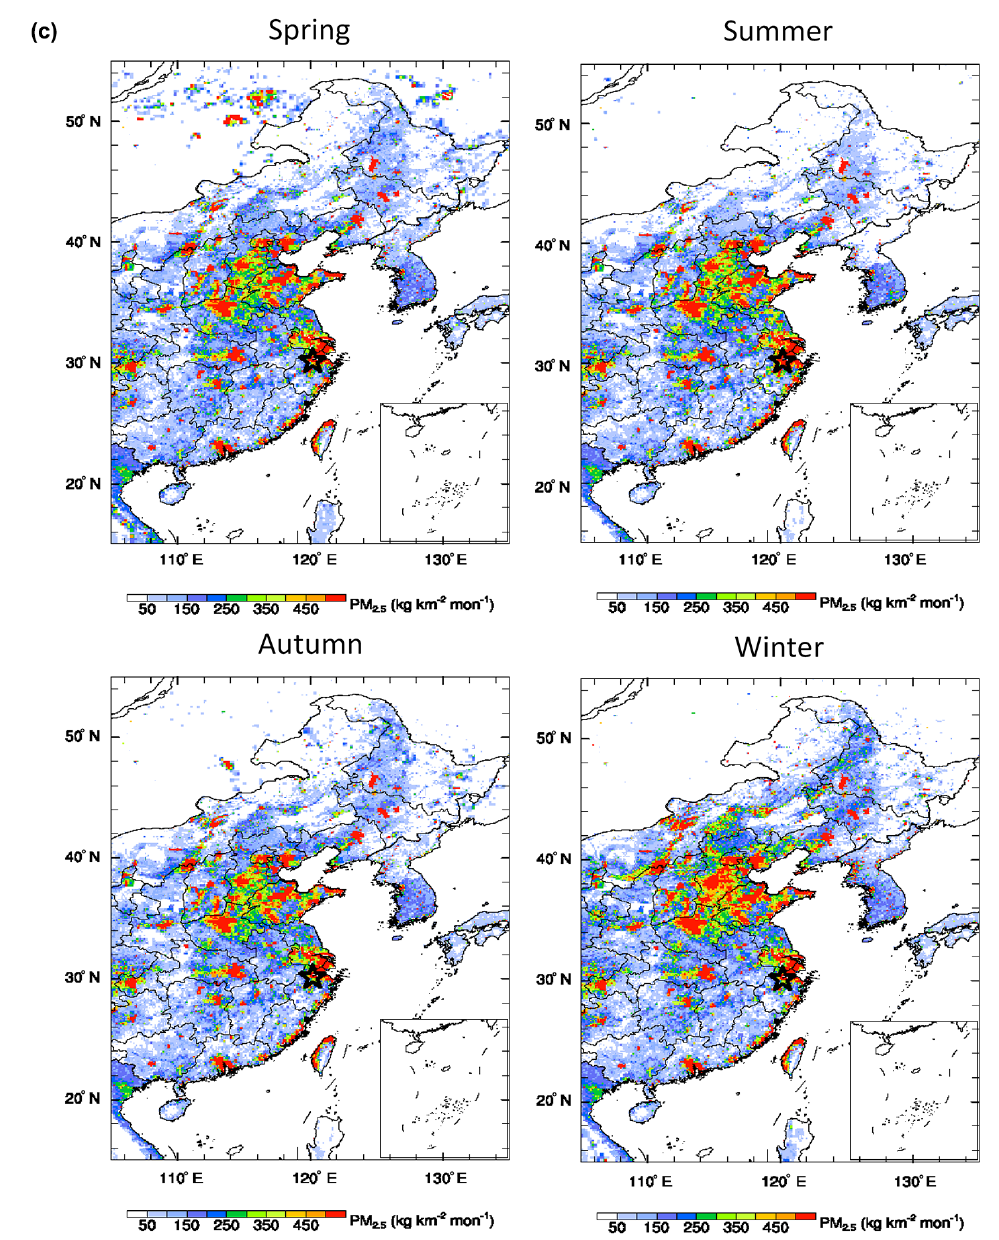
Figure 6. (a) Seasonal weighted potential source contribution function (WPSCF) maps of PM 2 . 5 in Hangzhou. The sampling site is marked by the star and the WPSCF values are displayed in color. (b) The zoomed view of Fig. 6a. (c) Seasonal and spatial distributions of PM 2 . 5 emissions (kgkm 2 mon − 1 ) at the surface layer in China. The sampling site is marked by the star.